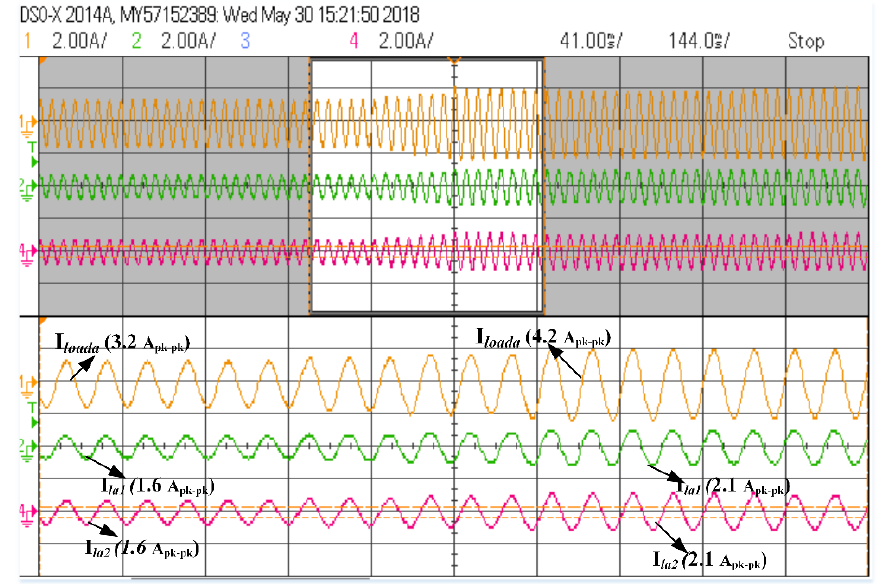
Figure 24. Parallel operation for increase in load.